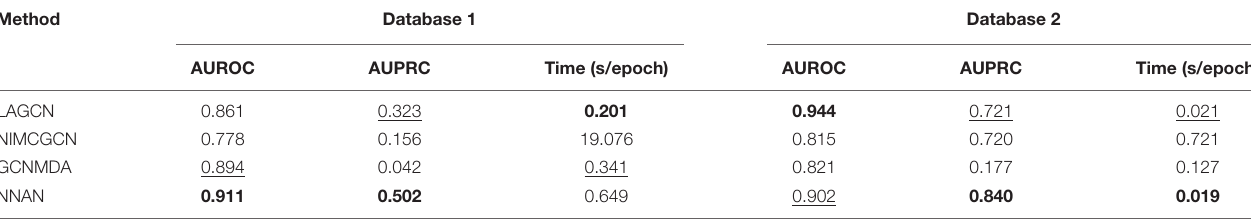
TABLE 2 | The performance comparison of DMA prediction.